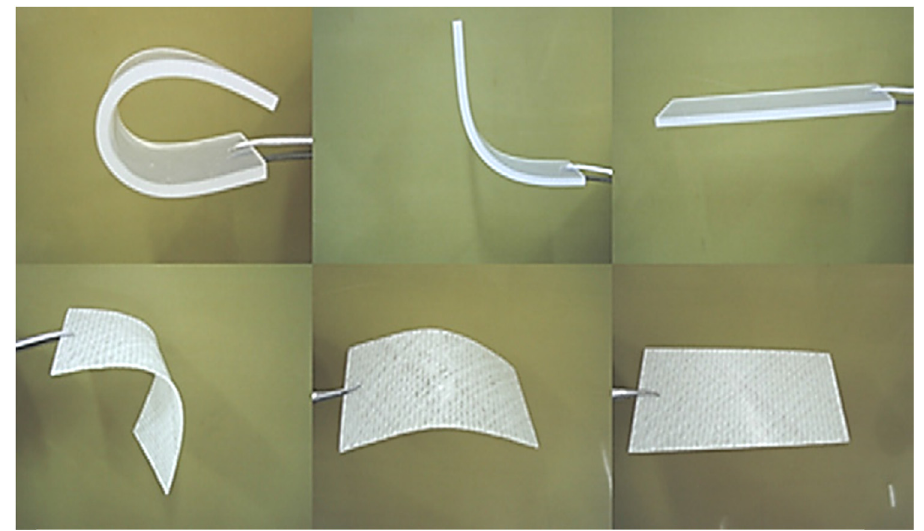
Figure 4: Shape recovery of neat polymer ( top row ) and reinforced shape memory composite ( bottom row ) ( 41 ) . Reproduced with permission from